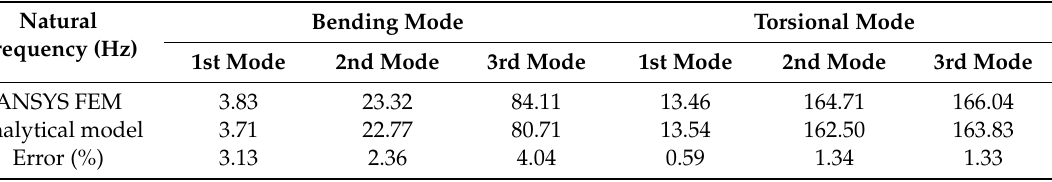
Figure 2. ( a–c ) The first three bending vibration modes, and ( d–f ) the first three torsional vibration modes by finite element simulation. The ( g ) bending and ( h ) torsional vibration modes by the derived analytical model. Table 2. The bending and torsional natural frequencies by finite element simulation and the derived analytical model.